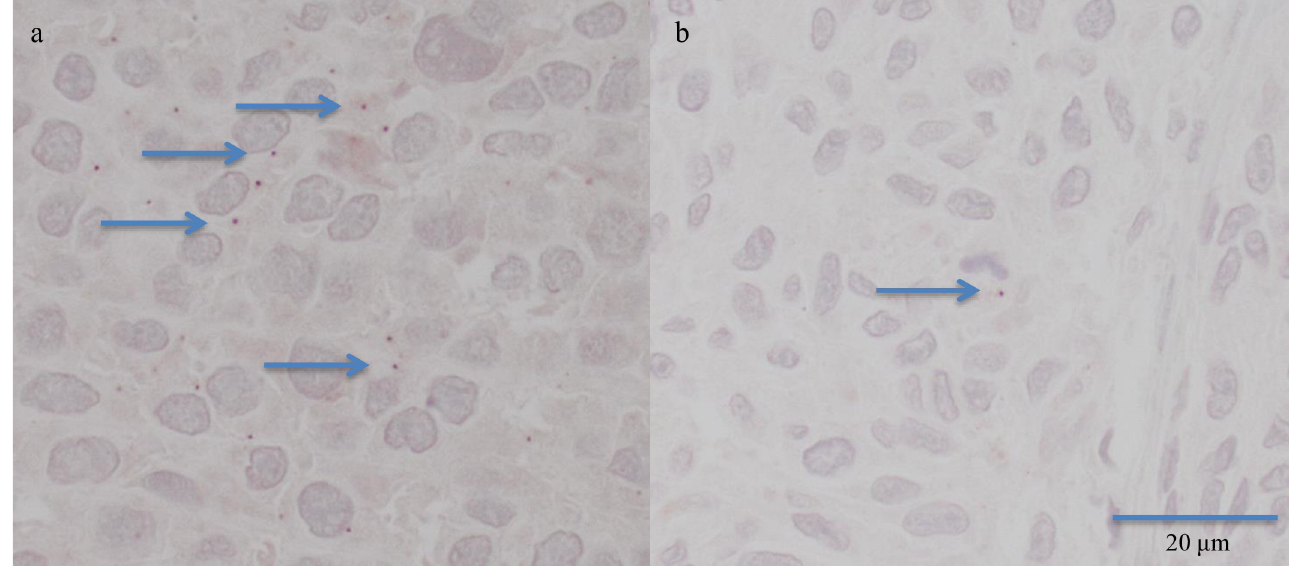
Fig 1. Immunohistochemistry with positive staining for pp65 in the form of small distinct granular structures, either in the nucleus or cytoplasm. In a) IR 3 (only part of the granules marked with an arrow), in b) IR 1, only 1 granule is visible (arrow), (x400).